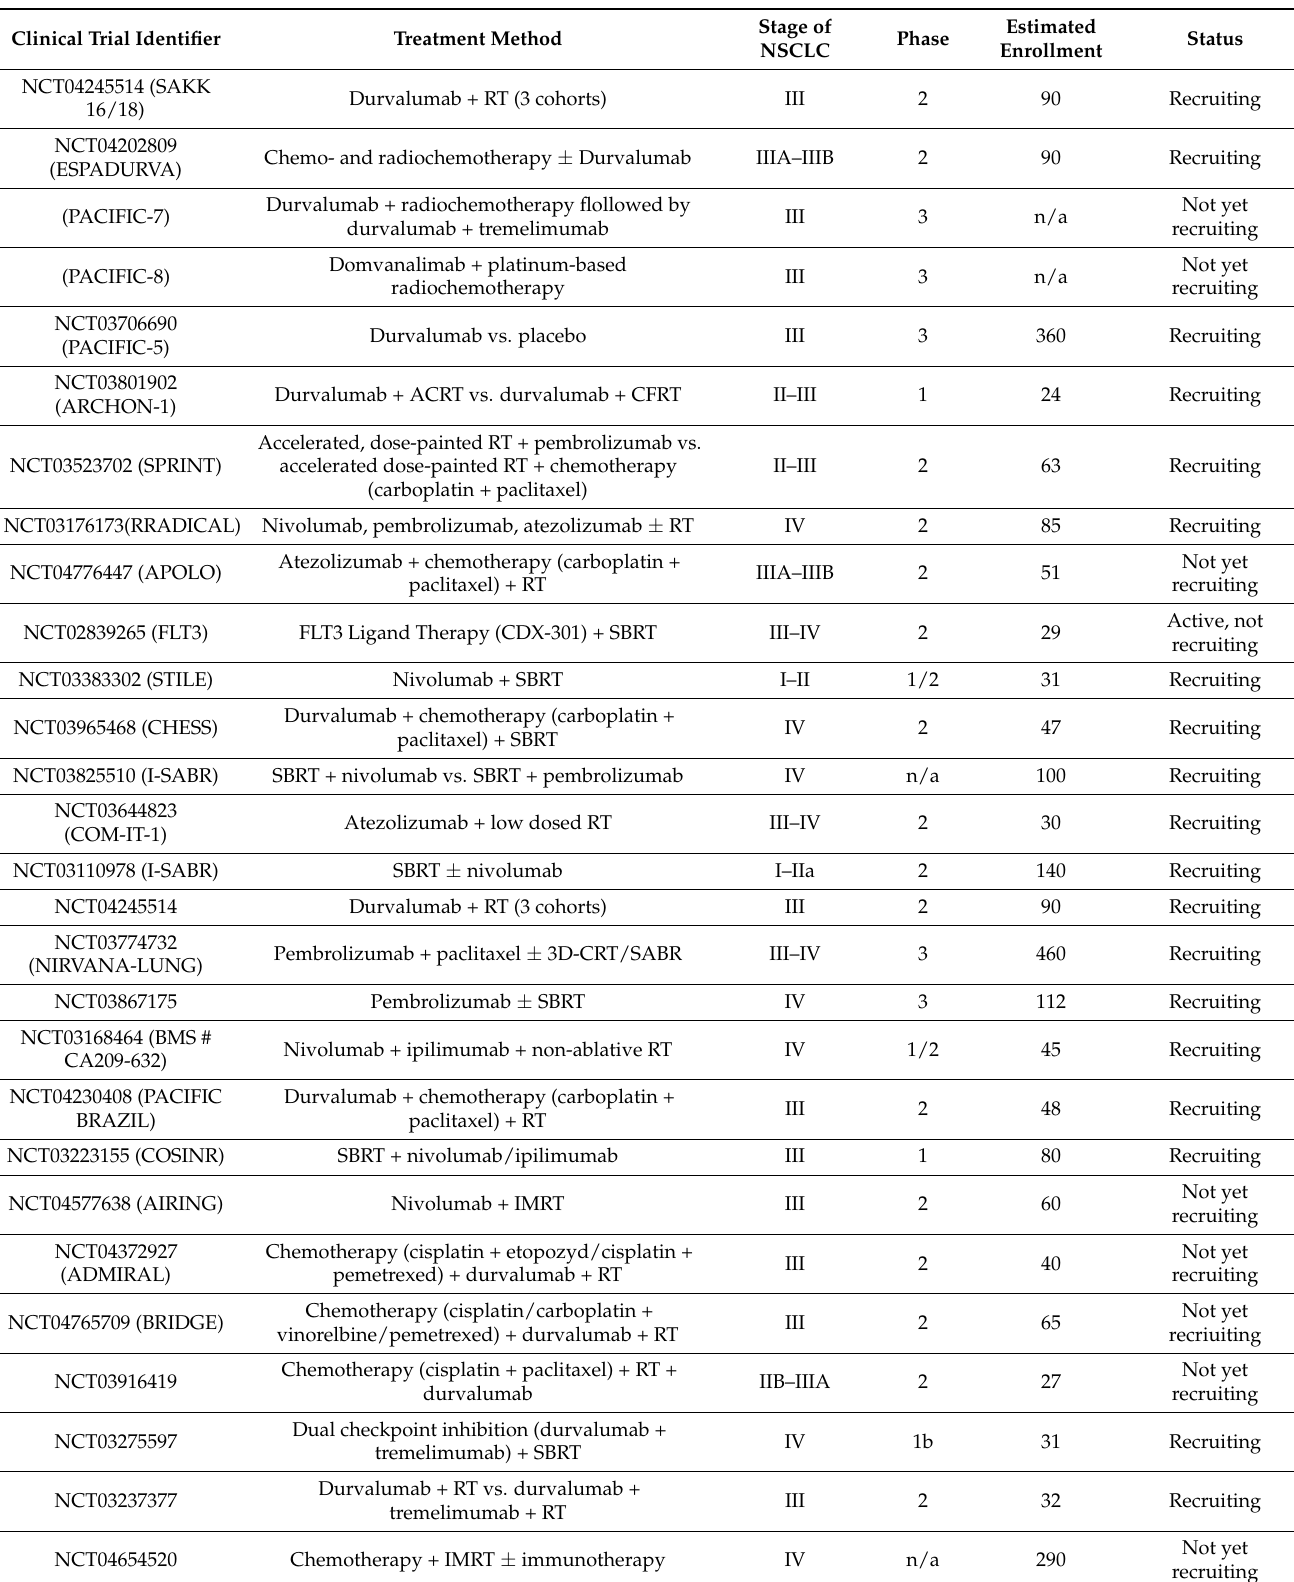
Table 1. Ongoing and future clinical trials investigating combined treatment based on immunotherapy and radiotherapy or radiochemotherapy in NSCLC